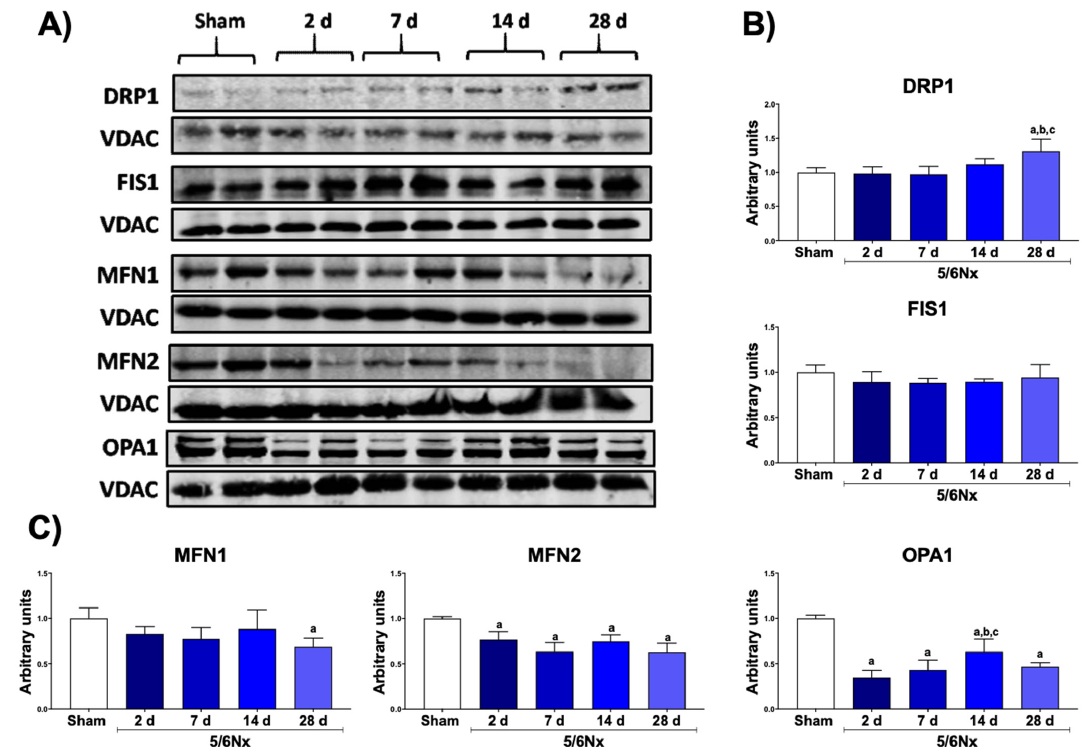
Figure 3. Alteration in mitochondrial dynamics in remnant renal mass. ( A ) Representative Western blots of the fission and fusion proteins. ( B ) Quantification of the fission proteins: dynamin-1-like protein (DRP1) and mitochondrial fission 1 protein (FIS1). ( C ) Quantification of the fusion proteins: mitofusin 1 (MFN1) and 2 (MFN2) and optic atrophy 1 (OPA1). Voltage-dependent anion channel (VDAC) was used as loading control. Data are the mean ± SEM, n = 4. Tukey test. a = p ≤ 0.05 vs. sham, b = p ≤ 0.05 vs. 2 days, c = p ≤ 0.05 vs. 4 days, 5/6Nx = 5/6 nephrectomy, d = days after 5/6Nx, sham = simulated operation/control group.